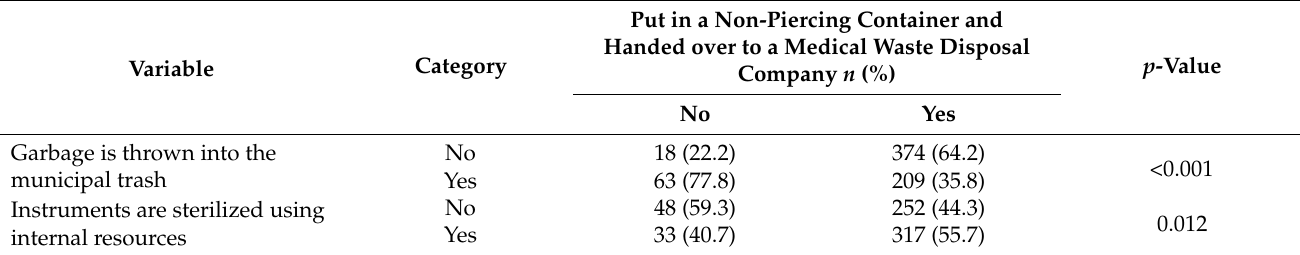
Table 5. Procedures using sharp tools and the choice of the correct form of disposal by beauty parlors.